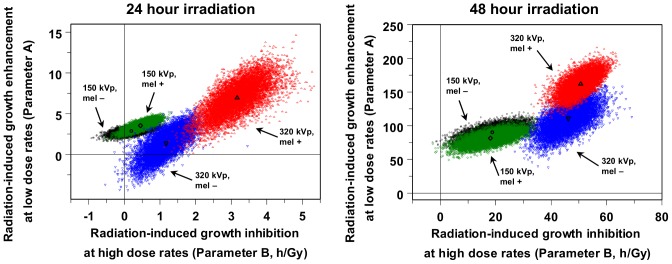
Analysis of best-fit model parameter values.The proposed model, Q = A(e, t, m) – [B(e, t, m) x R], which predicts the radiation effect on proliferation relative to background conditions (Q), based on radiation dose rate (R), X-ray peak energy (e), duration of irradiation (t), and cell melanization status (m), was fitted to 10,000 Monte Carlo simulated data sets, generated from each observed data set by nonparametric bootstrapping. This procedure was repeated for 8 observed data sets, which represent combinations of 150 or 320 kVp X-ray peak energy, 24 or 48 hour exposure duration, and positive or negative cell melanization status (mel+or mel –). Each “cloud” of points represents the spread of values for model parameters A and B which are consistent with the corresponding data set, randomly varied by bootstrapping. Black open symbols superimposed on each “cloud” represent best-fit parameter values to the observed data (unperturbed by bootstrapping).